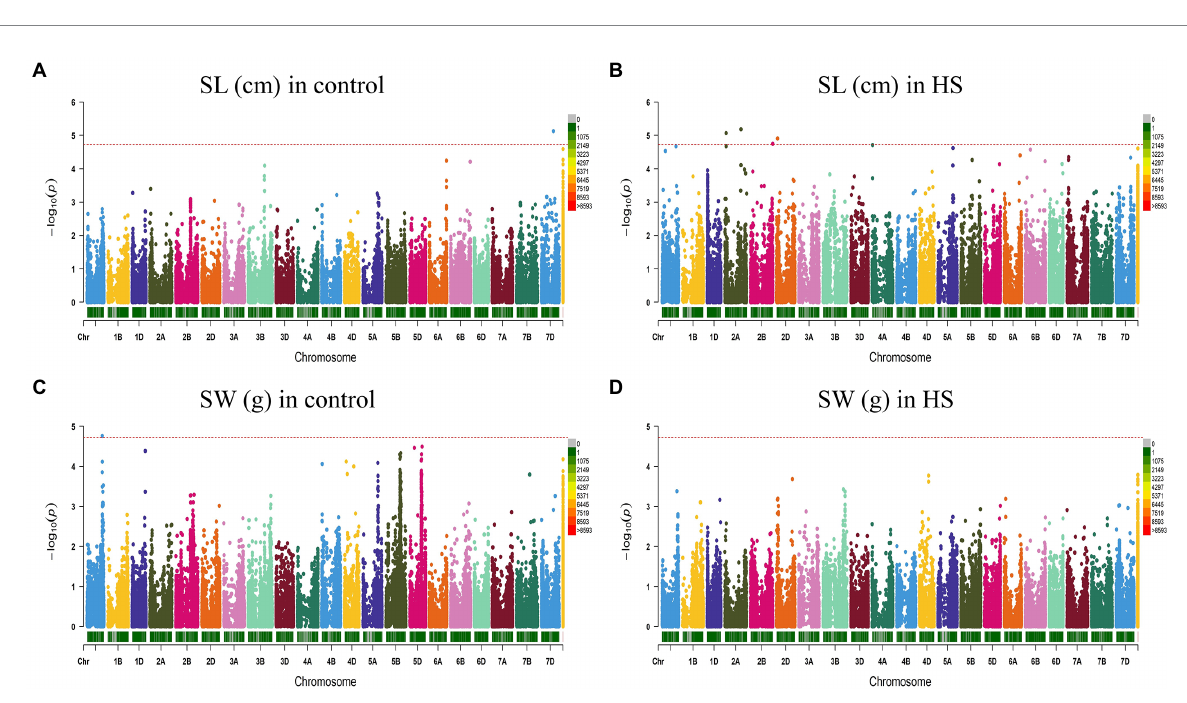
two HSPs at 3.14 Mb and 3.17 Mb away in upstream and downstream region, respectively. Three QTNs for SL (AX-111242222, AX-86167844, and AX-95156239) on chr6A,